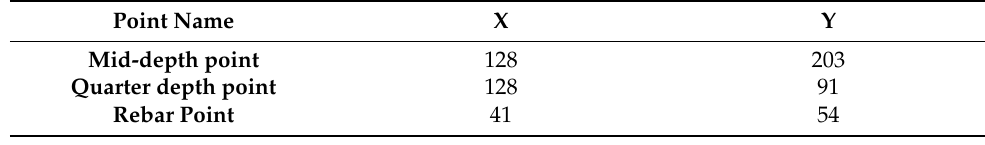
Table 1. Points for thermal response validation.